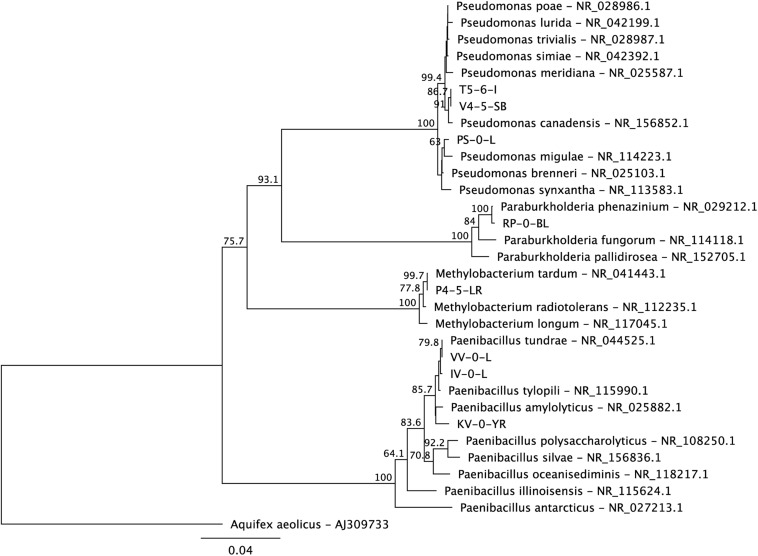
A maximum likelihood phylogenetic tree of the 16S rRNA genes of the new Lastensuo isolates in respect to the closest relative reference strains. The topology of the tree was tested by bootstrap analyses of 1000 random resamplings and nodes with > 50% bootstrap support are indicated. The scale bar represents number of nucleotide substitutions per site.